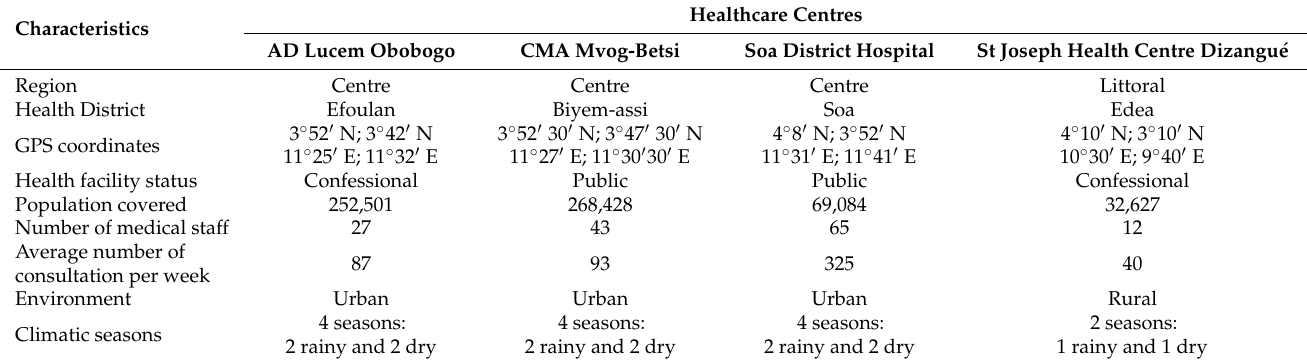
Table 1. Characteristics of the health care facilities where the survey was undertaken.